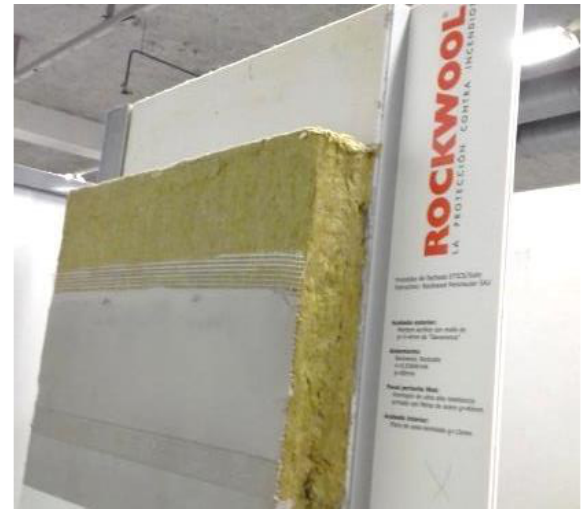
Figure 2. Panel, high embodied energy. Photo: César Arguedas.